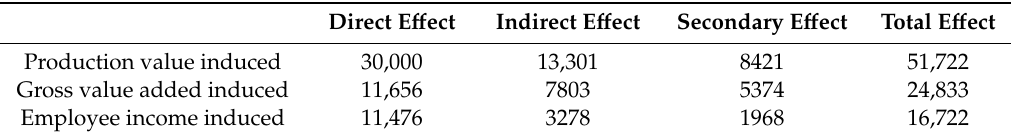
Table 6. The economic impact of constructing a concrete check dam (after unifying construction costs; unit is thousand